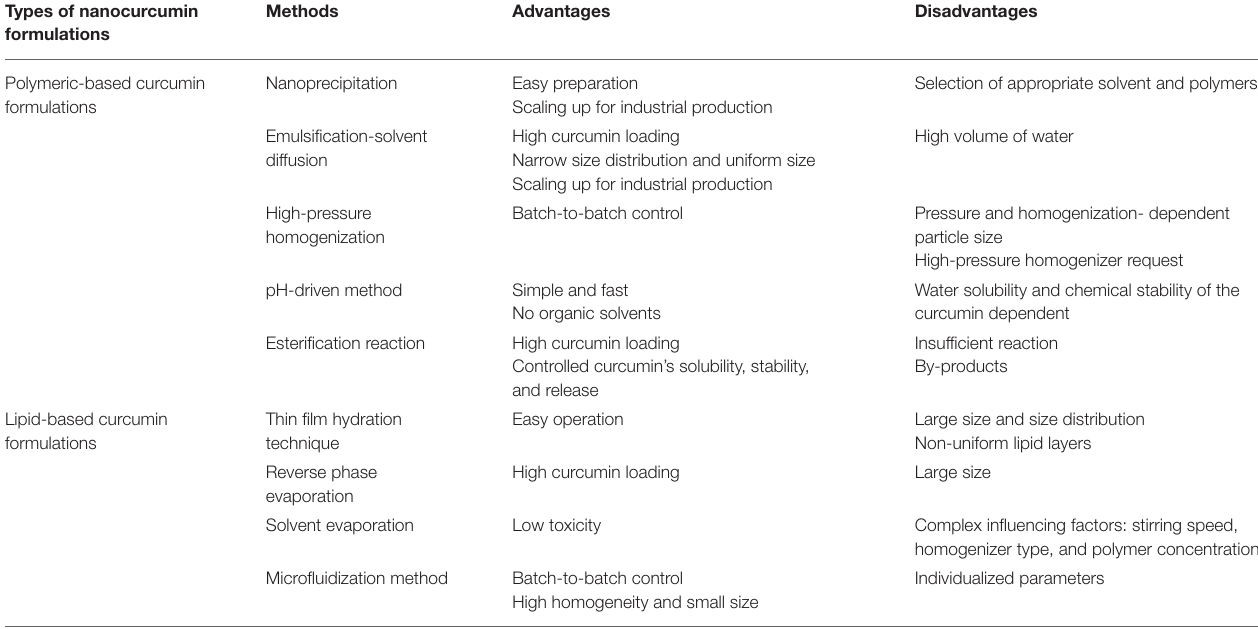
TABLE 2 | Comparison of recent approaches used in nanocurcumin